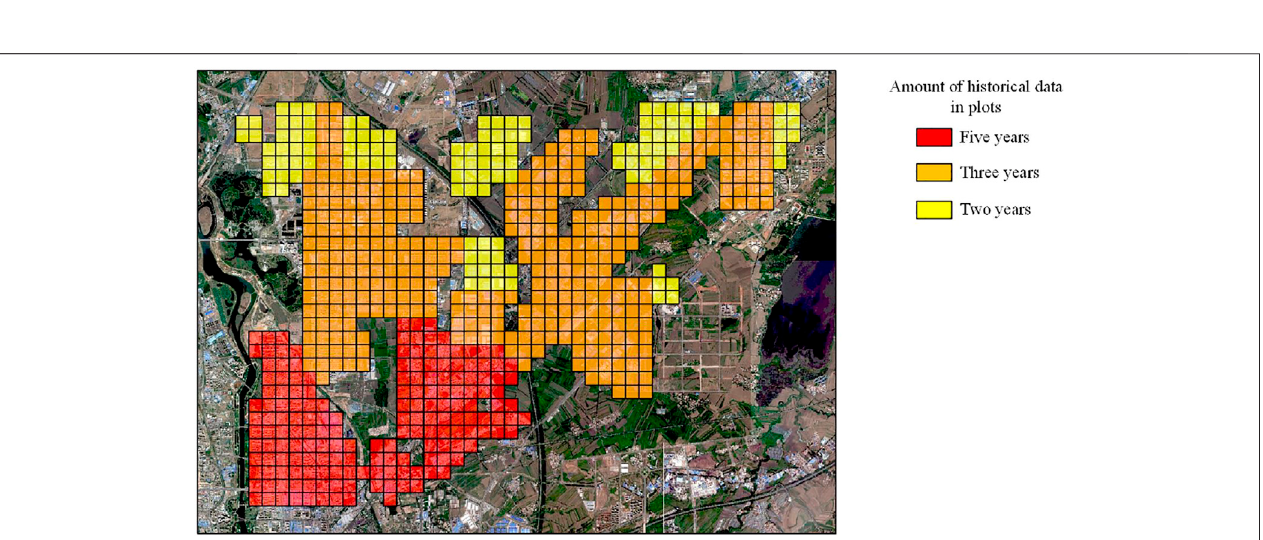
FIGURE 6 | Study area and the corresponding remote sensing images.